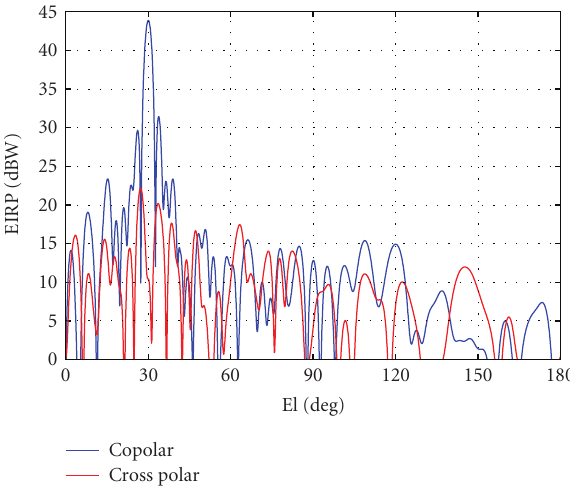
Figure 20: Typical Elevation Tx Antenna Pattern at 14.25 GHz, 30 o elevation pointing over the